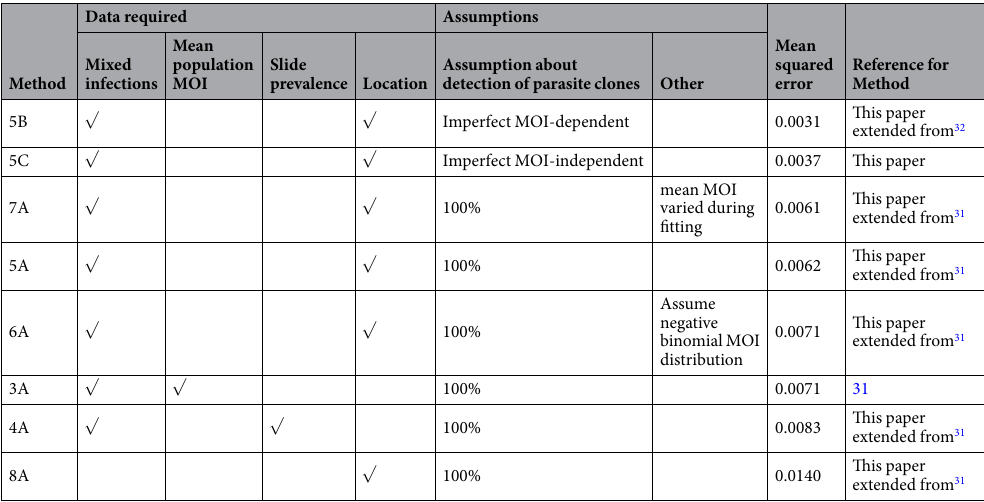
Table 1. Estimating mutant frequencies using different methods: validation using a test dataset from Tanzania 39 . Frequencies of the 540E mutation are estimated in 24 areas in 2 different years. We compare frequencies estimated from the full dataset with information on MOI and resistance markers for each individual (Method 2, see Methods) with frequencies estimated from partial summary data using different methods. We show mean squared error to quantify the difference between the two sets of estimates in each comparison. The methods are ordered by increasing mean squared error; lowest indicates more similar estimates. The column ‘mixed infections’ indicates that data on the proportion of mixed wild type-resistance infections was used to estimate frequencies. ‘Slide prevalence’ indicates that mean MOI was estimated using the relationship in Fig. 4. ‘Location’ indicates that longitude and latitude of the survey location were used to obtain estimates of slide- prevalence from the Malaria Atlas Project, in order to estimate mean MOI using Fig. 4 45 . Where imperfect detection of parasite clones was assumed, this was included when fitting to both the full and partial datasets (letters A to C after the Method number denote assumption about detection; see Methods. For example, in the first row, method 5B is compared to method 2B, in the 2 nd row method 5C is compared to method 2C